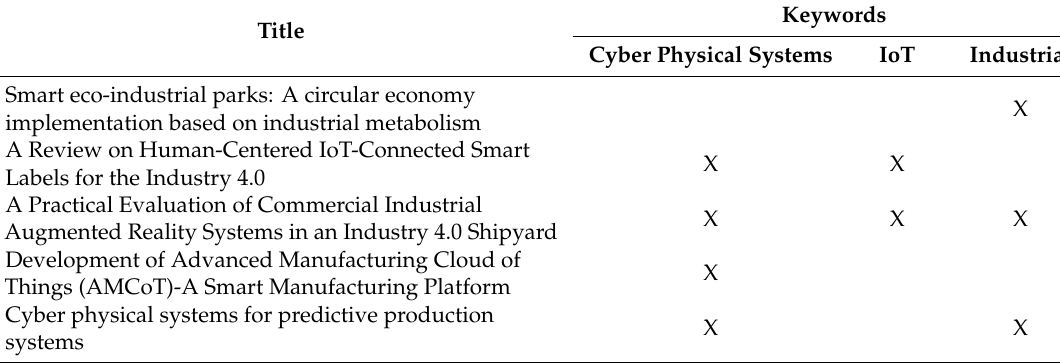
Table 4. The most used Keywords (source